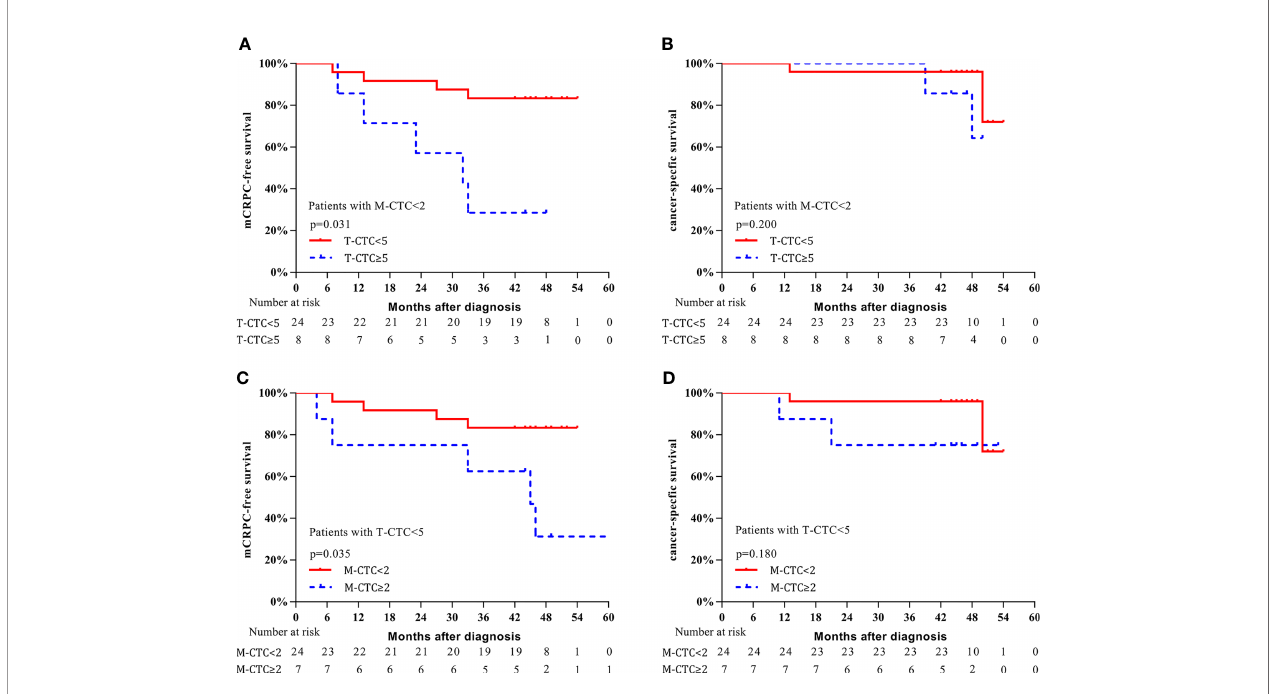
FIGURE 5 | Kaplan – Meier curves of survival outcomes. (A) mCRPC-free survival strati fi ed according to T-CTC count in the subgroup of M-CTC<2. (B) CSS strati fi ed according to T-CTC count in the subgroup of M-CTC<2. (C) mCRPC-free survival strati fi ed according to M-CTC count in the subgroup of T-CTC<5. (D) CSS survival strati fi ed according to M-CTC count in the subgroup of